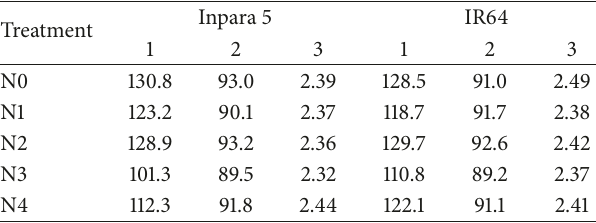
Table 5: The fertilizing effect for two rice varieties on several yield components at condition of dirty water submergence